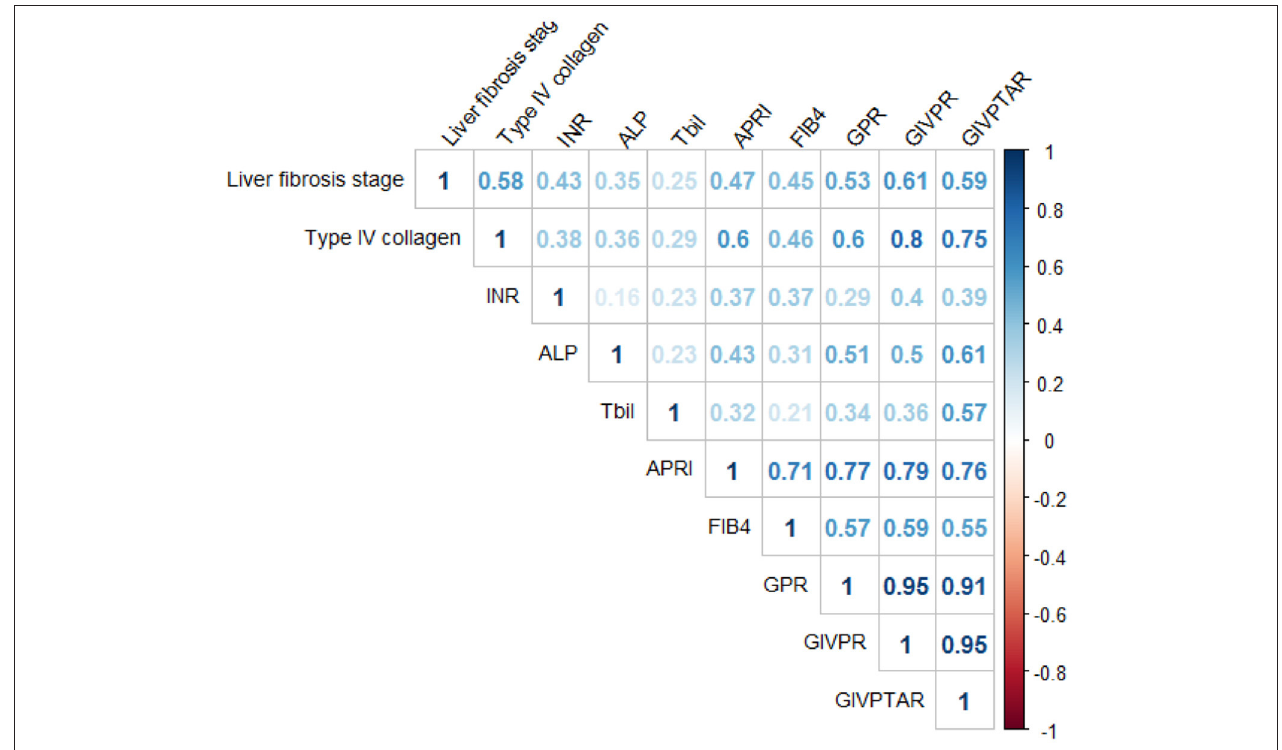
FIGURE 2 | Correlation between the serum indexes and liver fibrosis score.